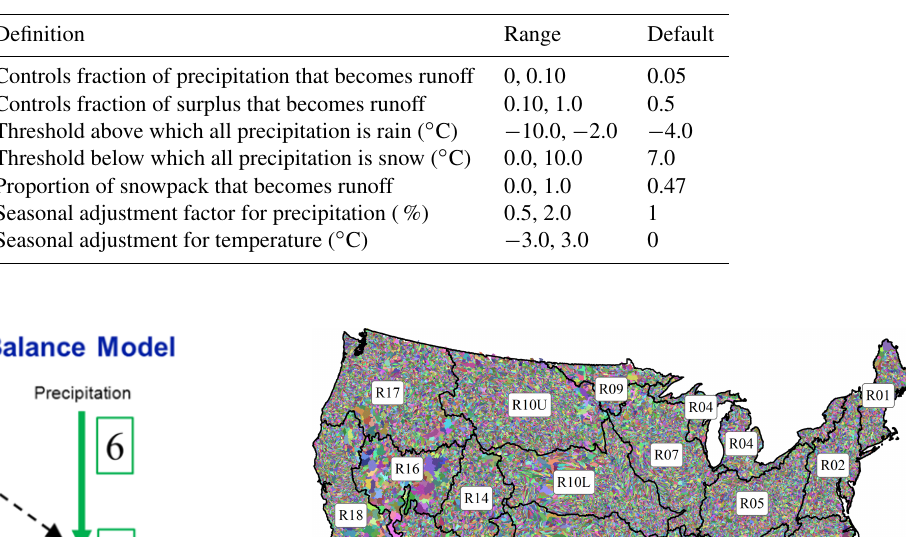
Table 1. Monthly water balance model parameters and ranges.